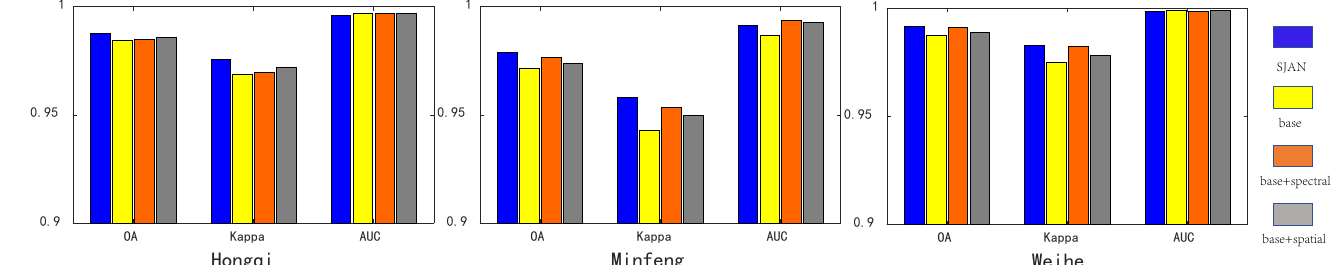
Figure 13. Comparison of different feature-extraction methods on OA, Kappa, and AUC values.